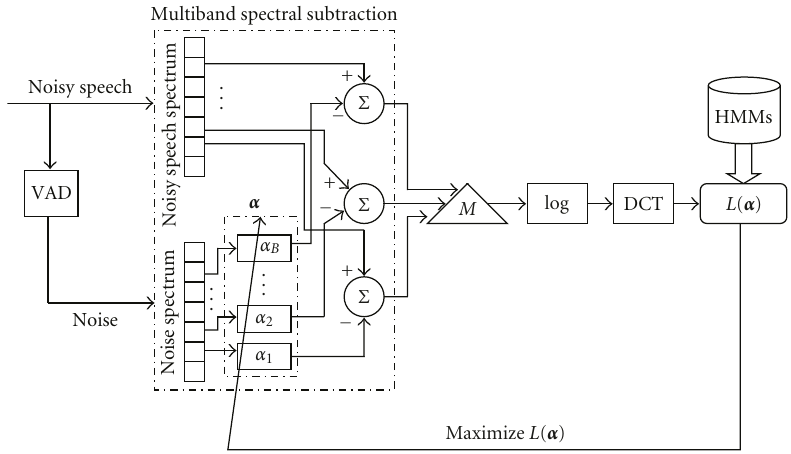
Figure 1: Block diagram of the proposed